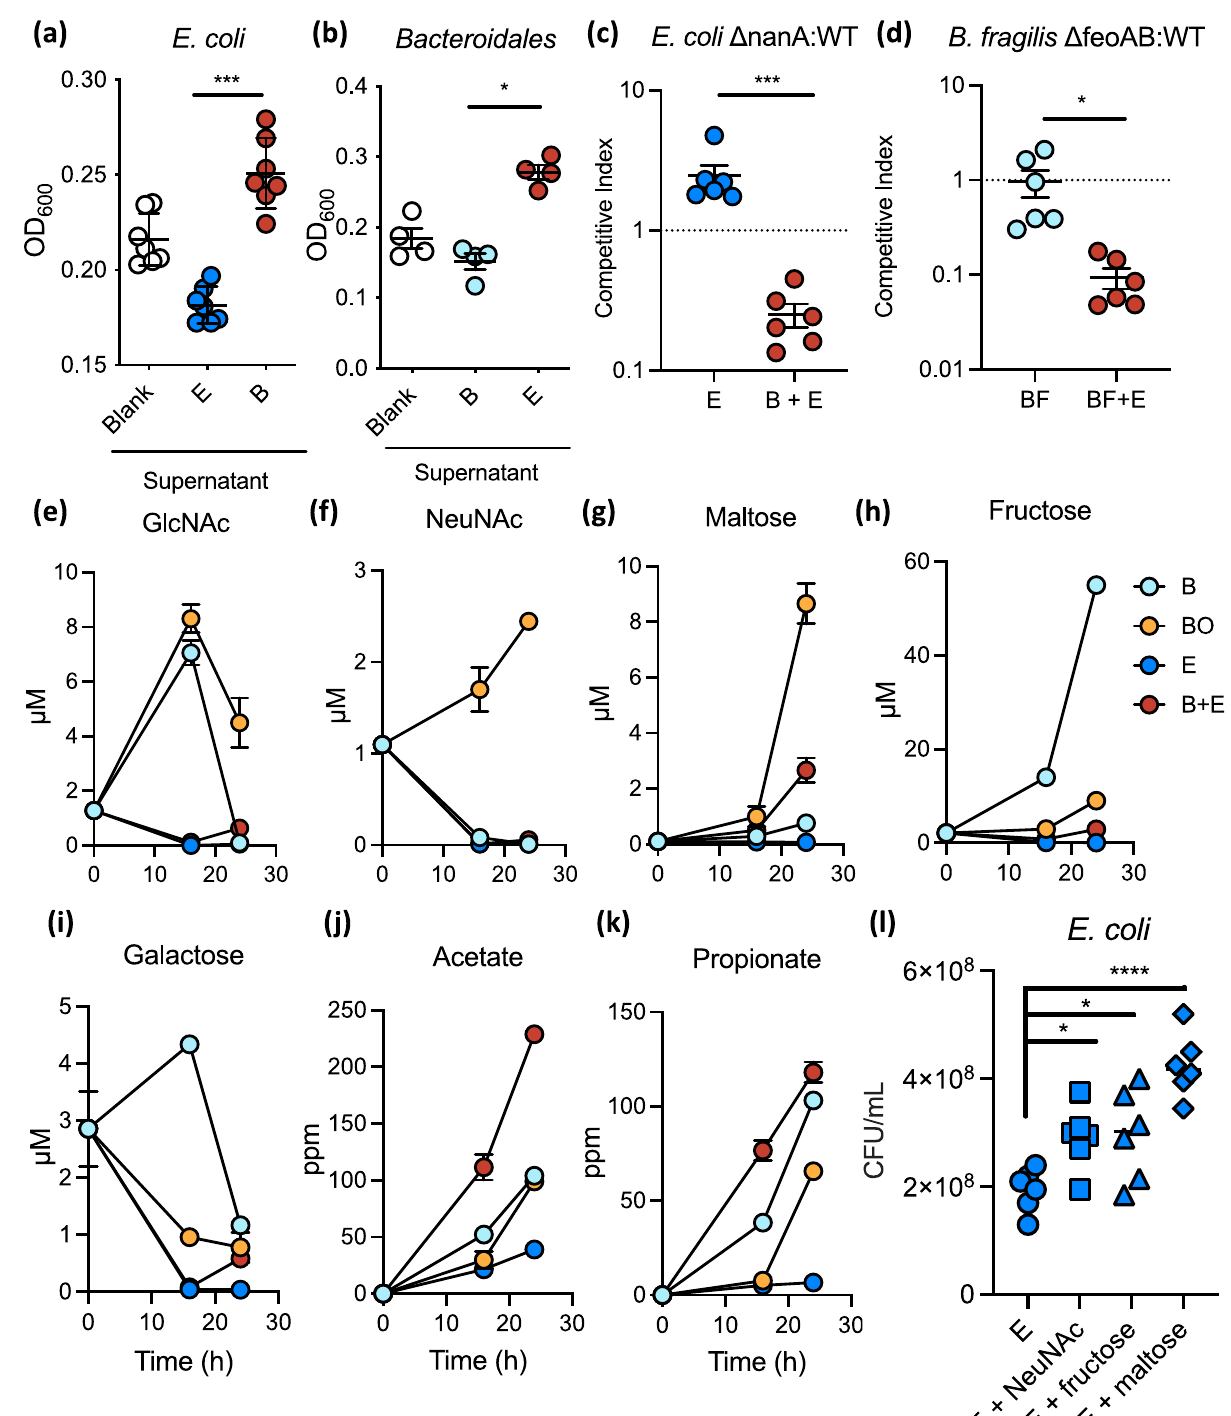
Fig. 4 E. coli and Bacteroidales exchange soluble metabolites, including sialic acid and heme. a , b Growth of E. coli ( n = 7) ( a ) and Bacteroidales ( n = 4) ( b ) at 24 endpoint, as determined by optical density at 600 nm (O.D.600) in the sterile- fi ltered supernatants of blank media ( “ Blank ” ), a 24 h E. coli culture ( “ E ” ), or a 24 h Bacteroidales culture ( “ B ” ). c Competitive index of Δ nanA E. coli , de fi cient in sialic acid metabolism, compared to wild-type in the presence or absence of Bacteroidales ( n = 6). d Competitive index of Δ feoAB B. fragilis , de fi cient in iron uptake, compared to wild-type strain 638 R in the presence or absence of E. coli ( n = 6). e – k Metabolite abundance in sterile- fi ltered bacterial culture supernatants over time ( n = 3). Mean + / − SEM are displayed: e N-acetylglucosamine (GlcNAc); f N-acetylneuraminic acid (NeuNAc, sialic acid); g maltose; h fructose; i galactose; j acetate; k propionate. l Growth of E. coli in MAL-M media supplemented with 1 mM of free sugars ( n = 6). Signi fi cance was determined by ANOVA with post hoc Dunnett ’ s test ( a , b , l ), or by two-sided t test ( c , d ). * P value < 0.05, ** P value < 0.01, *** P value < 0.001. B Bacteroidales mix, BF B. fragilis , BO B. ovatus, E E. coli mix. Source data are provided as a Source Data fi le. Exact P values and test statistics are reported in Supplementary Table